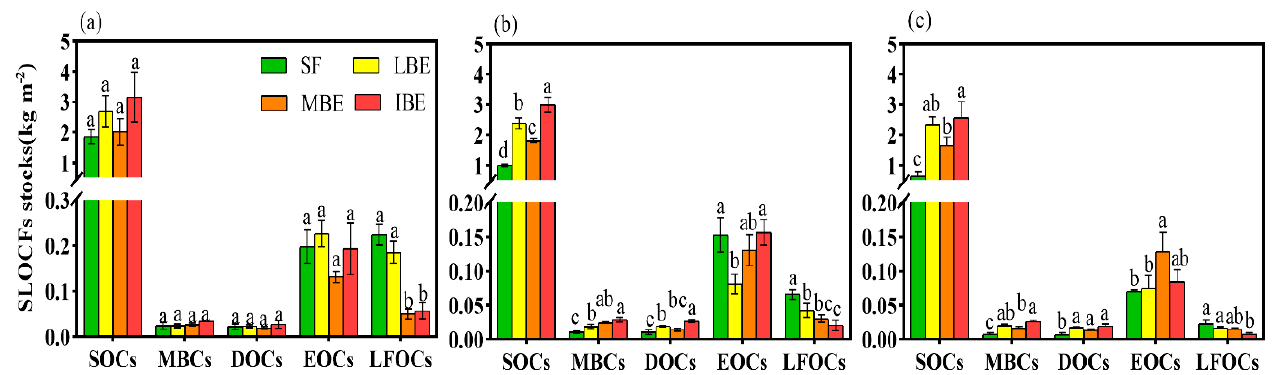
Figure 3. SLOCF stocks at different bedrock exposure rates. SOCs, MBCs, DOCs, EOCs and LFOCs represent the stocks of SOC, MBC, DOC, EOC and LFOC, respectively. SF (secondary forest); LBE (light bedrock exposure); MBE (moderate bedrock exposure); IBE (intense bedrock exposure). Different lowercase letters indicate significant differences ( p < 0.05). ( a – c ) Soil depths of 0–10 cm, 10–20 cm and 20–30 cm, respectively.